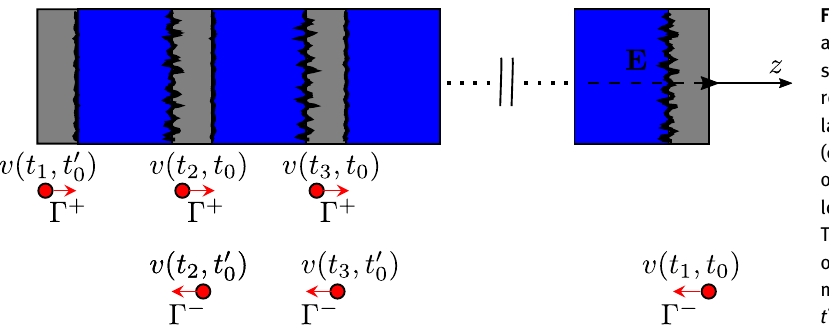
Figure 1: Schematic diagram of the origin of asymmetric current flow ina semiconductor superlattice due to differences in interface roughness depending on the sequence of layers. GaAs layers are depicted in blue (color online) and AlAs layers in gray (color online). The interface of GaAs over AlAs has lower quality than that of AlAs over